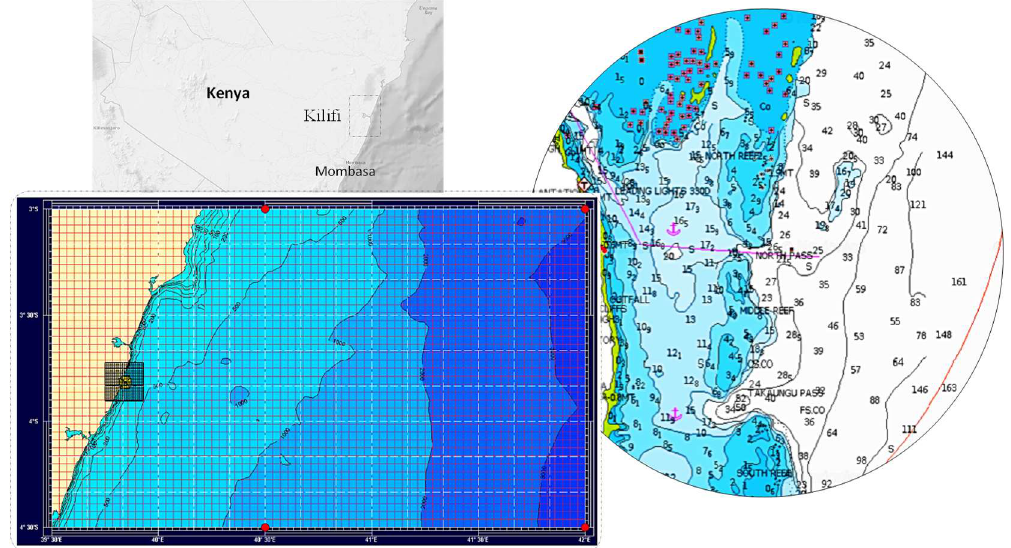
Figure 2. Studied location in Kilifi (3.815° S, 39.846° E), ca. 60 km north of Mombasa, Kenya. The Yellow dashed circle represents the data extraction point ( Fugro -No. 162230-1-R0). Local bathymetry and costal features are shown within the circle.